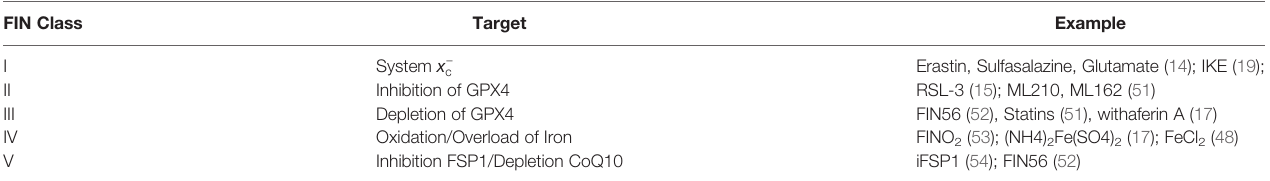
TABLE 1 | Principal Ferroptosis